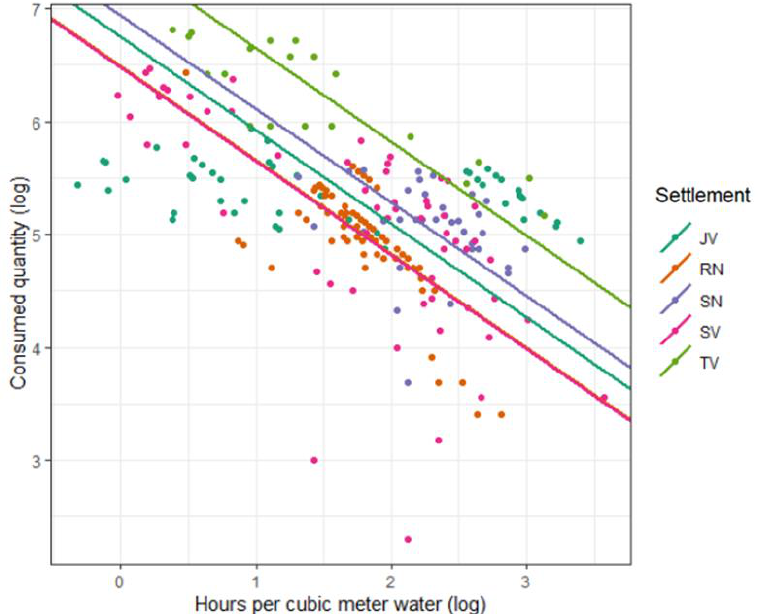
Figure A3. The effect of the settlement on the intercept estimated in Model B. Note that the Figure does not display the variation on the household level even though this is included in the model. Also note that the fitted lines for settlements RN and JV have almost identical shapes, such that RN is not visible in this plot.